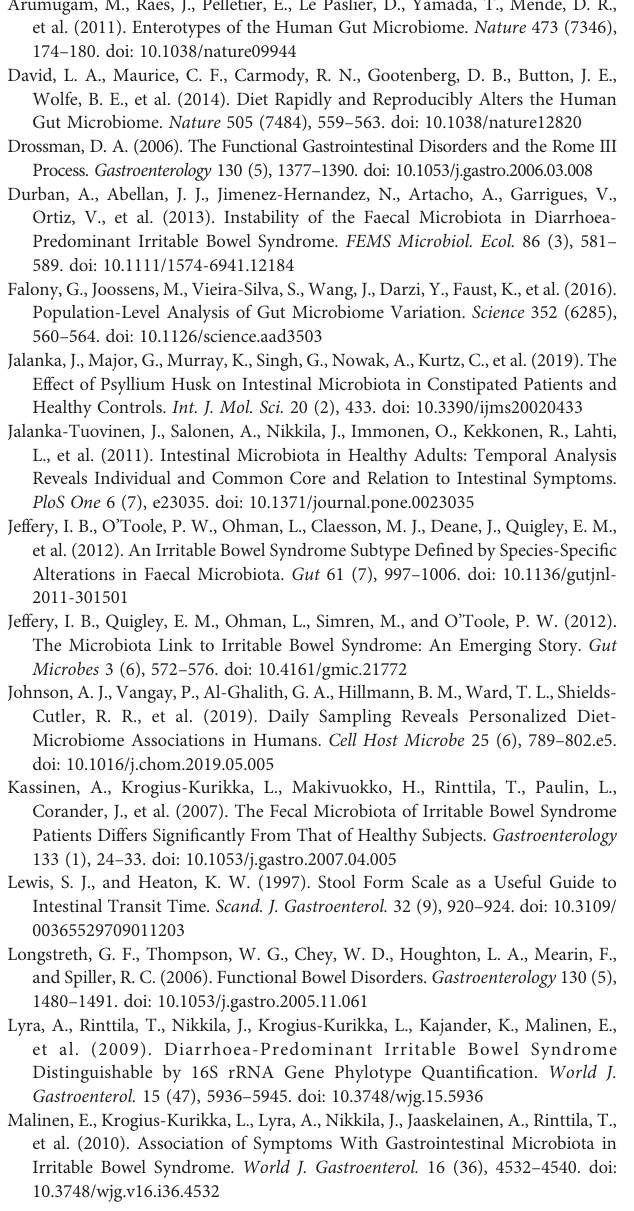
signi fi cant. (A) Firmicutes, (B) Bacteroidetes, (C) Actinobacteria, (D) Verrucomicrobia, (E) Proteobacteria. Supplementary Figure 4 | (A) Generalized UniFrac PCoA plot per individual (different colors) and for healthy subjects vs. IBS patients (see fi gure annotations). (B) Average within-subject beta diversity (generalized UniFrac) for healthy subjects vs. IBS patients, signi fi cance tested using Mann Whitney U test, p = 0.80. Supplementary Figure 5 | Bray Curtis Dissimilarity for days 2-7 compared to day 1 for IBS patients (A) and healthy subjects (B) . Different colors representing individual subjects; black and dashed line representing the mean Bray Curtis